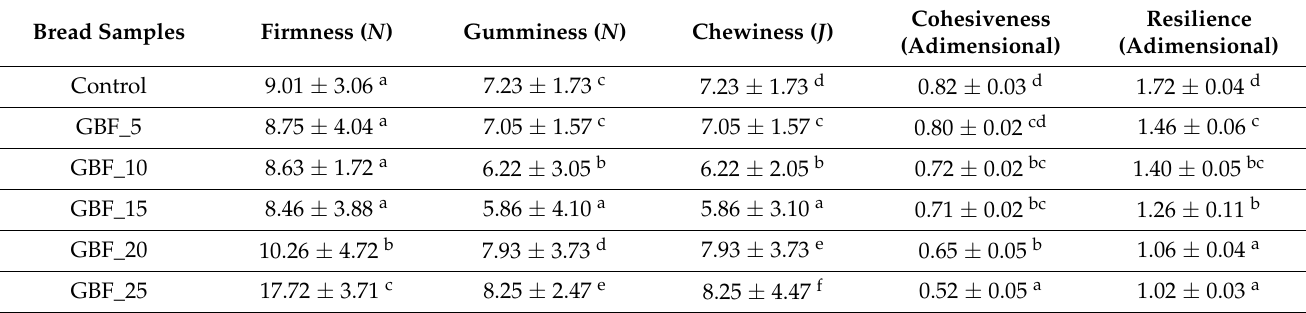
The results are the mean ± standard deviation ( n = 3). Bread samples containg germinated bean flour, GBF: a–f, mean values in the same column followed by different letters are significantly different ( p < 0.05).